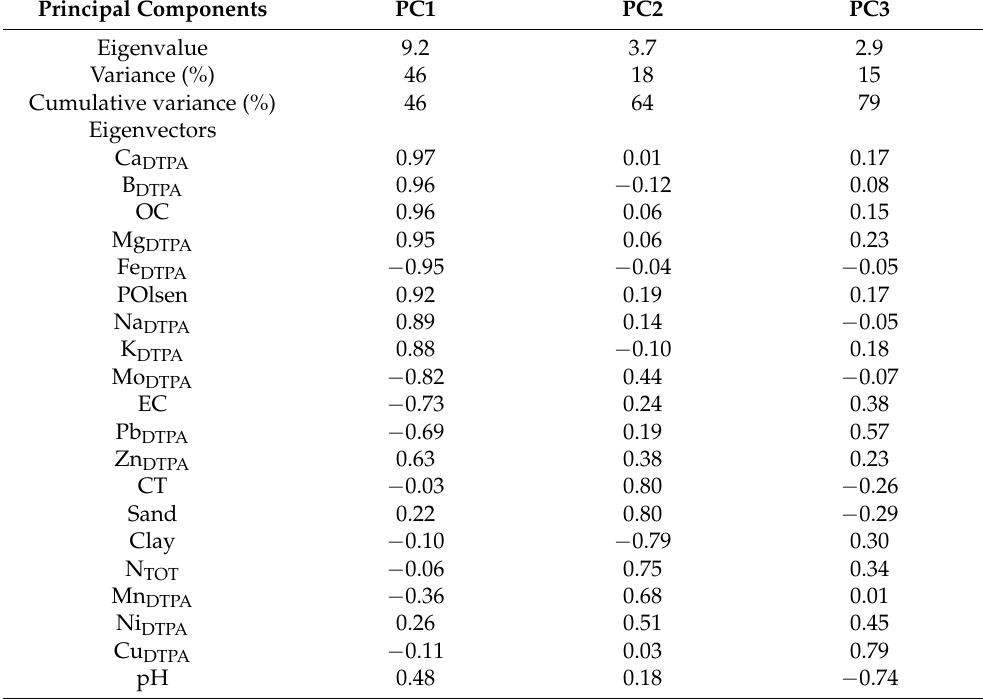
Table 4. Eigenvalues, variance explained, and loading values of the selected physical and chemical variables on the axes identified by principal components analysis for the differently managed